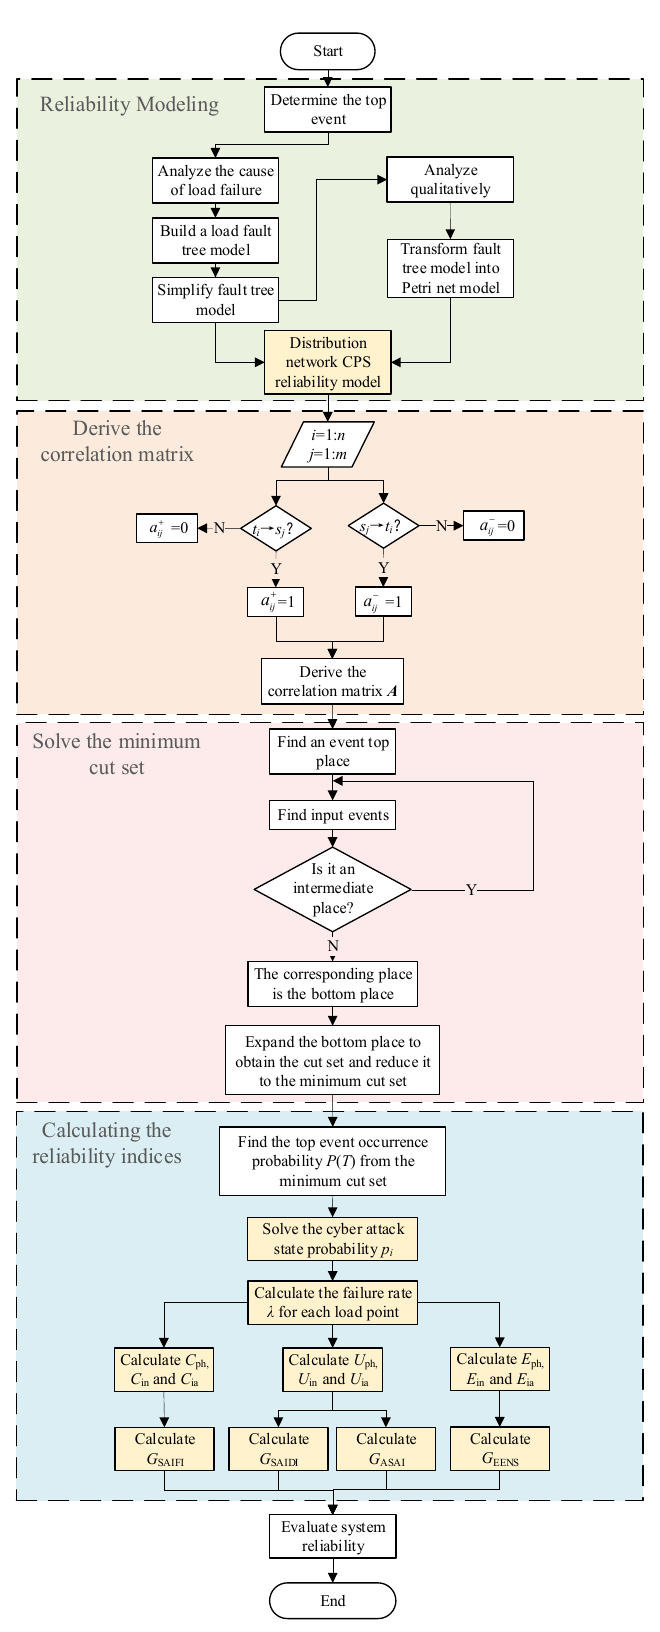
Figure 11. Flow chart of distribution network CPS reliability assessment.